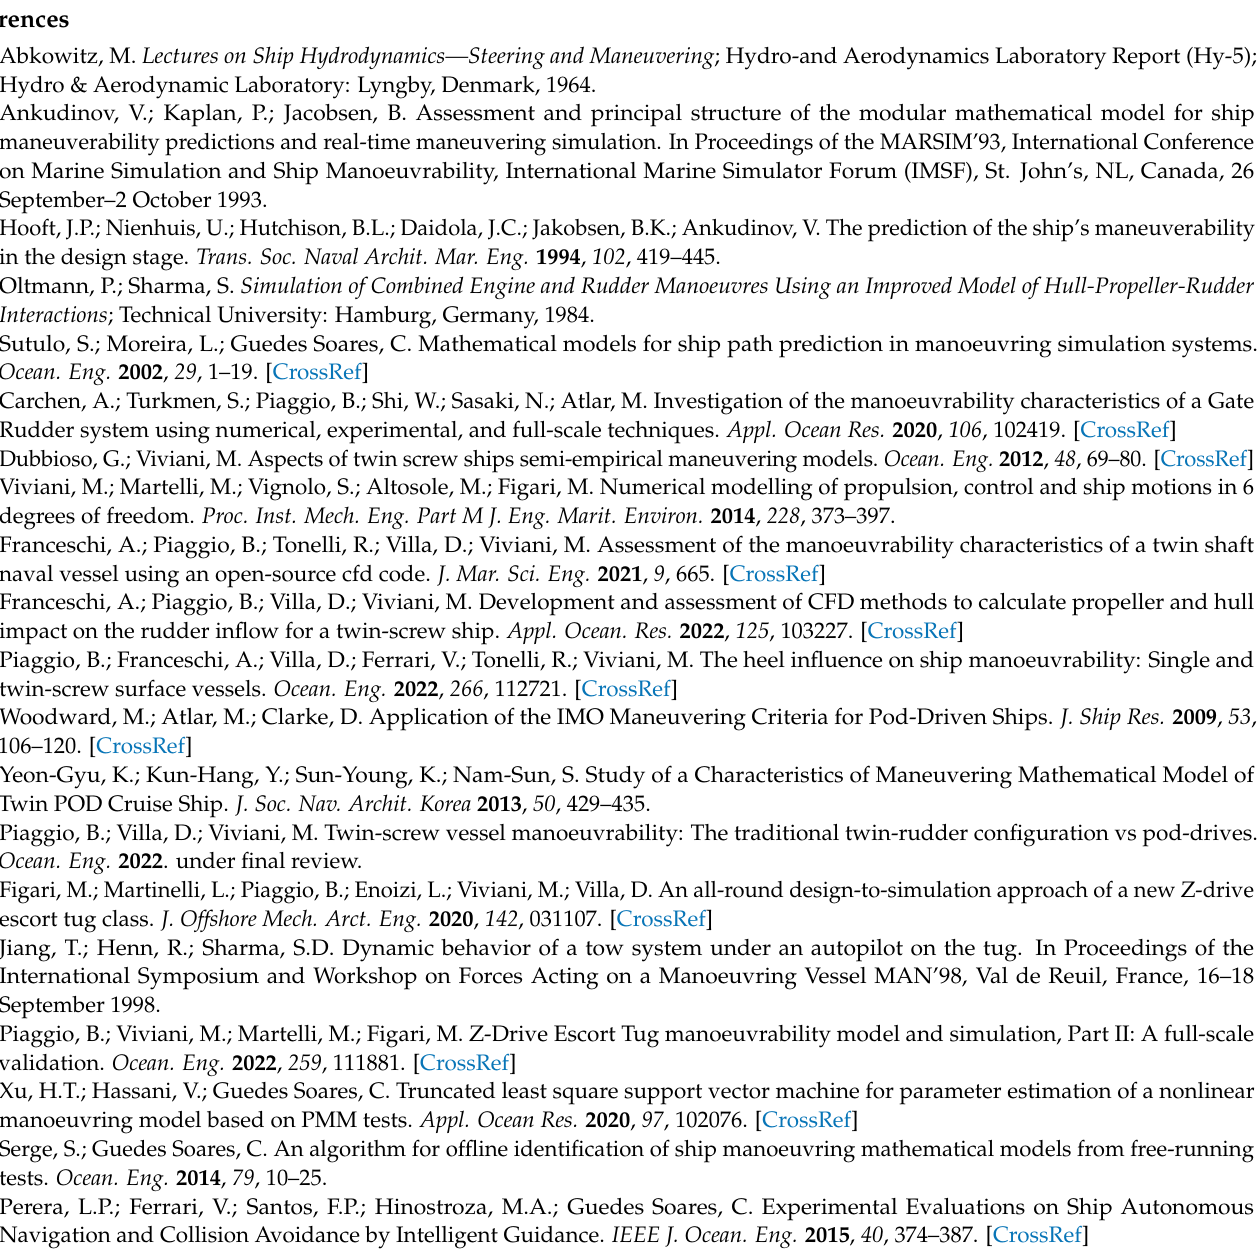
Figure A8. SMG x-Eq Failures.